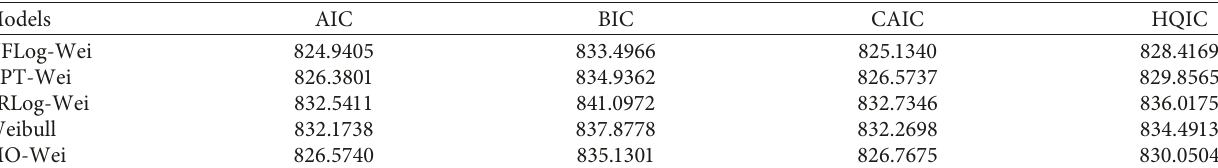
Table 12: The values of AIC, BIC, CAIC, and HQIC of the fitted models for Data 3.